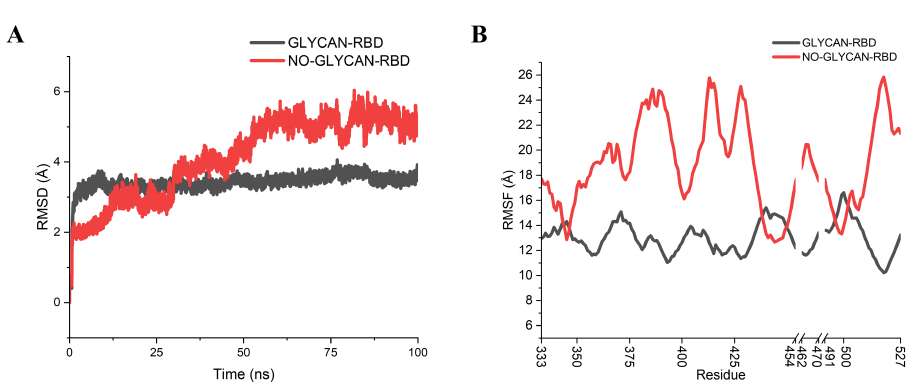
Figure 2. RMSD, RMSF analysis of GLYCAN and NO-GLYCAN RBD regions. GLYCAN system in black; NO-GLYCAN system in red; ( A ) RMSD analysis of antigenic RBD; ( B ) RMSF of antigenic RBD.